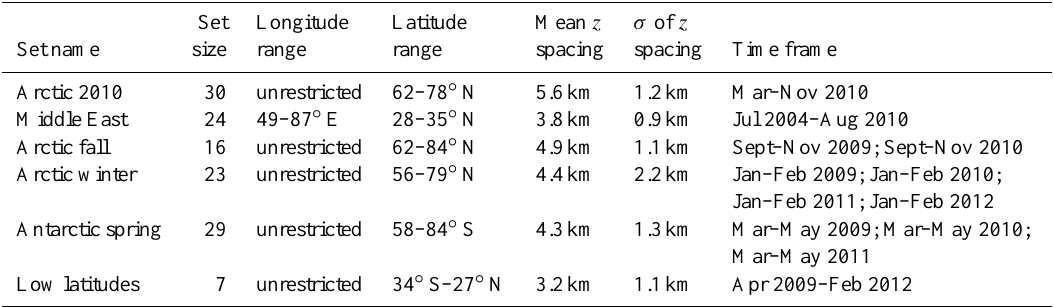
Table 2. List of ACE-FTS occultation sets analysed by GGG, showing the number of occultations each contains, their zonal coverage, season, and altitude spacing. Set Longitude Latitude Mean z σ of z Set name size range range